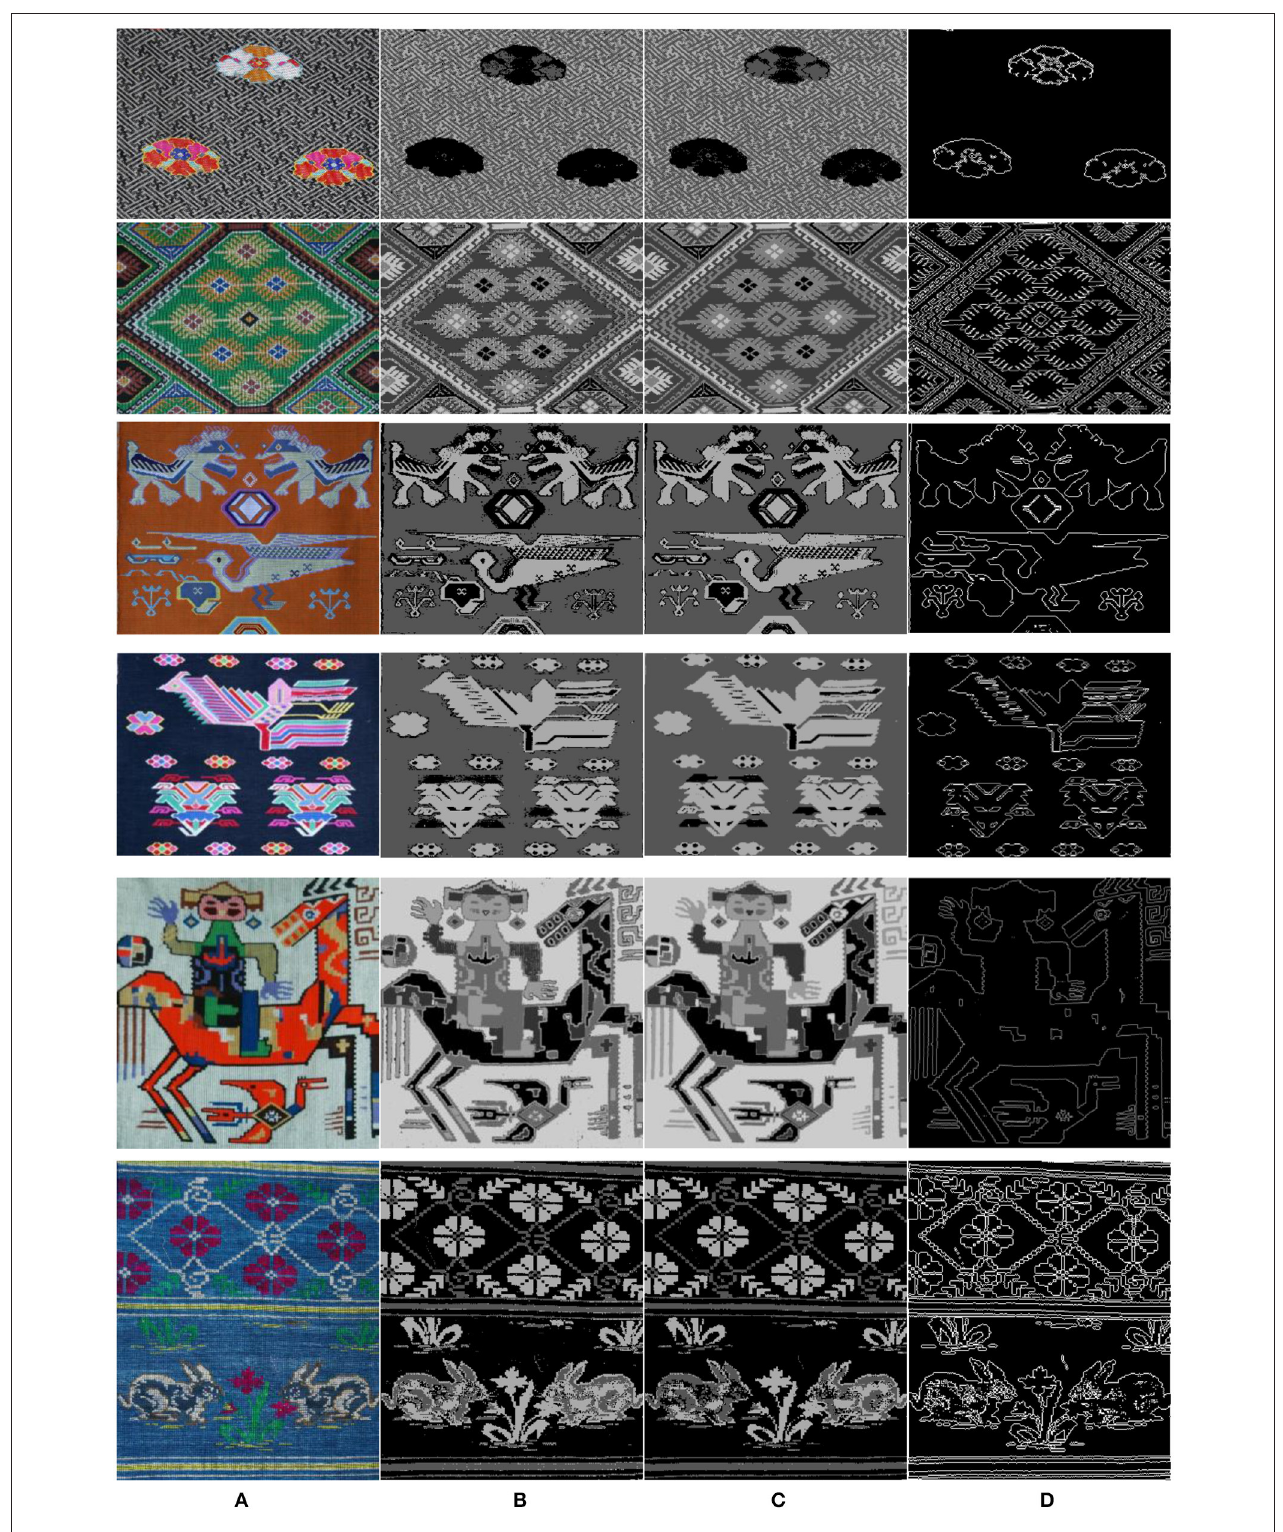
FIGURE 11 | Clustering and optimization results of Tujia brocades. (A) Image: Original. (B) Cluster. (C) Optimization. (D) Mask.